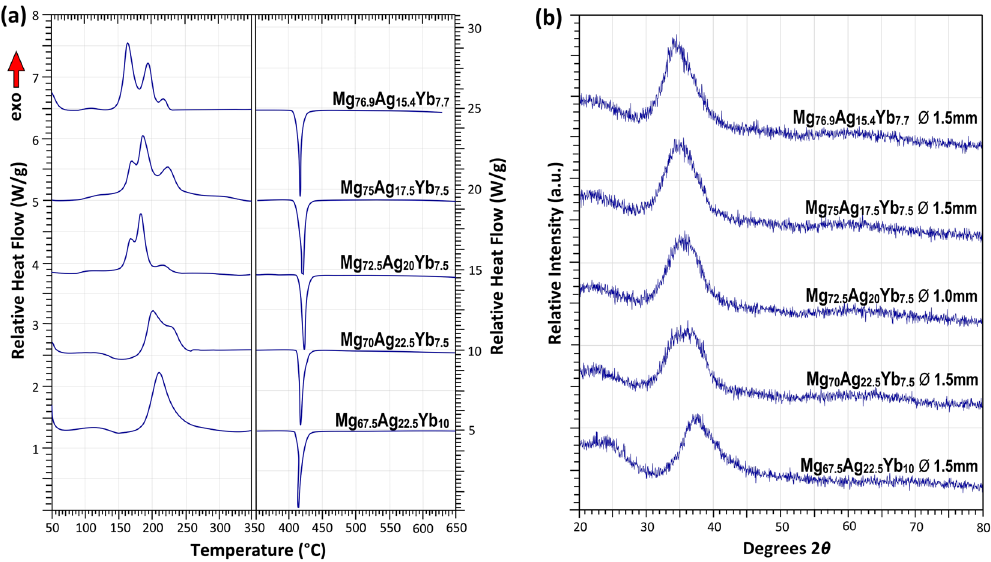
Figure 3. Selected ( a ) DSC and ( b ) XRD traces of Mg–Ag–Yb